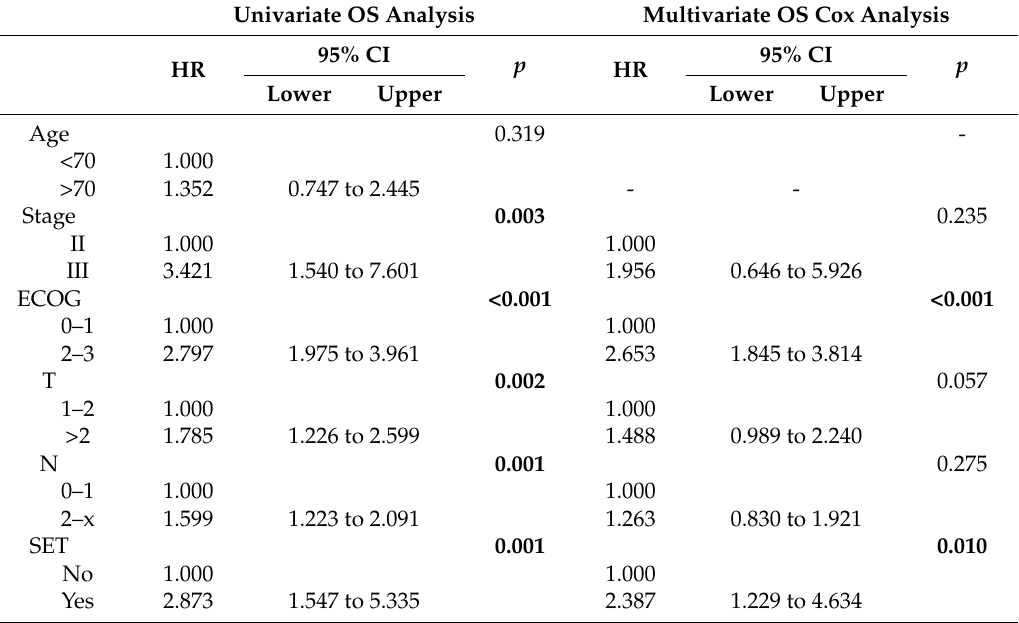
Figure 4. Kaplan-Meier analyses for SET expression in early-stage CRC patients: ( A ) Overall survival; Figure 4. Kaplan ‐ Meier analyses for SET expression in early ‐ stage CRC patients: ( A ) Overall and ( B ) time to metastasis ( n = 87). survival; and ( B ) time to metastasis ( n = 87). Table 3. Univariate and multivariate Cox analyses in the cohort of 149 patients with early-stage CRC. Univariate OS